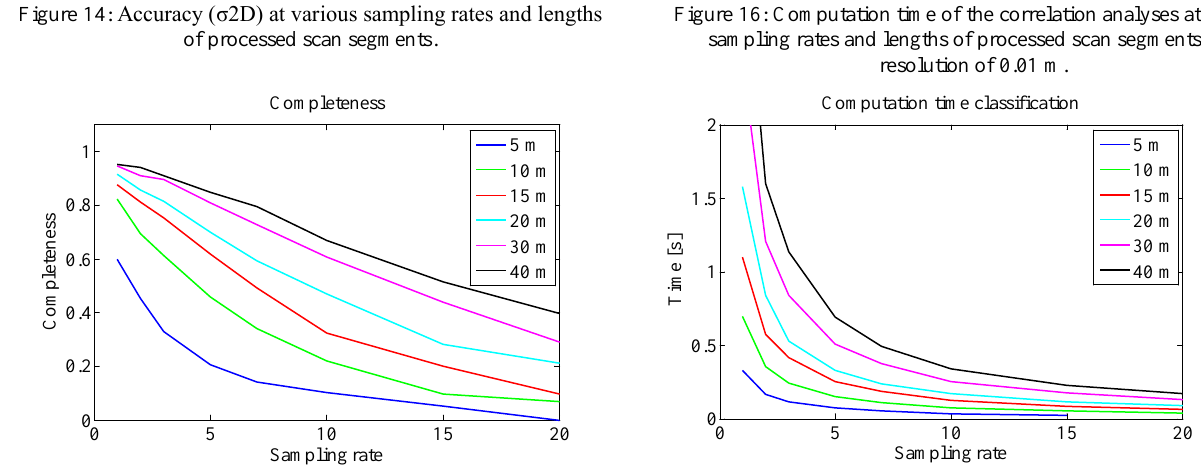
Figure 17: Computation time of the classification step at various sampling rates and lengths of processed scan